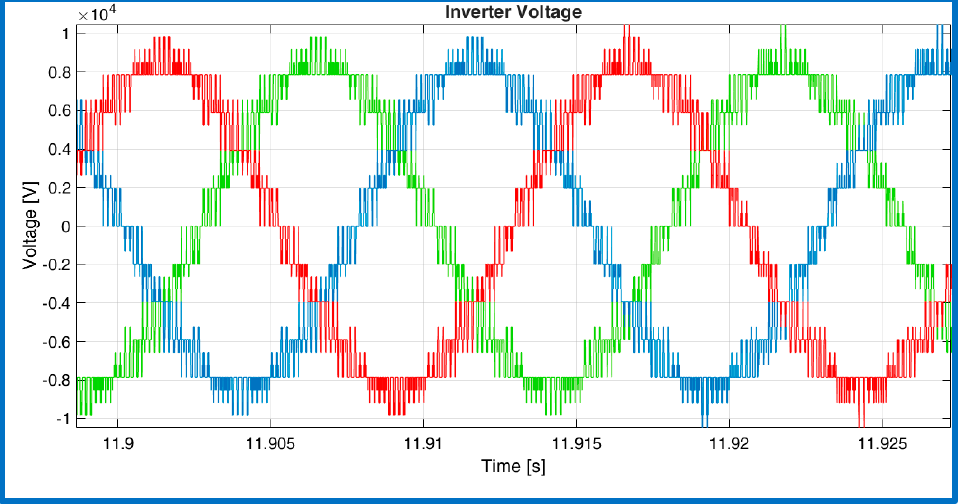
Figure 16. Three-phase inverter voltages.